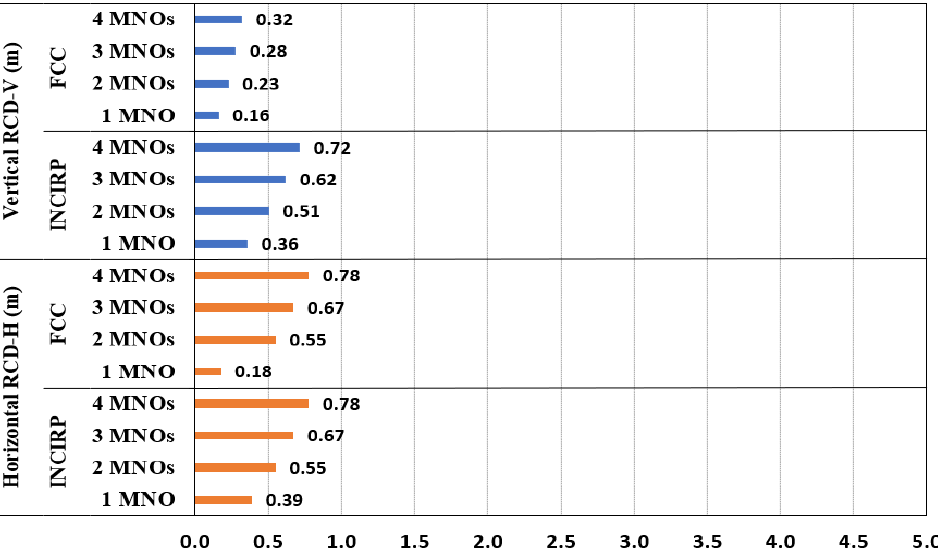
Figure 11. The R CD for shared IBS-DAS site, referencing the ICNIRP and FCC limits for GP.